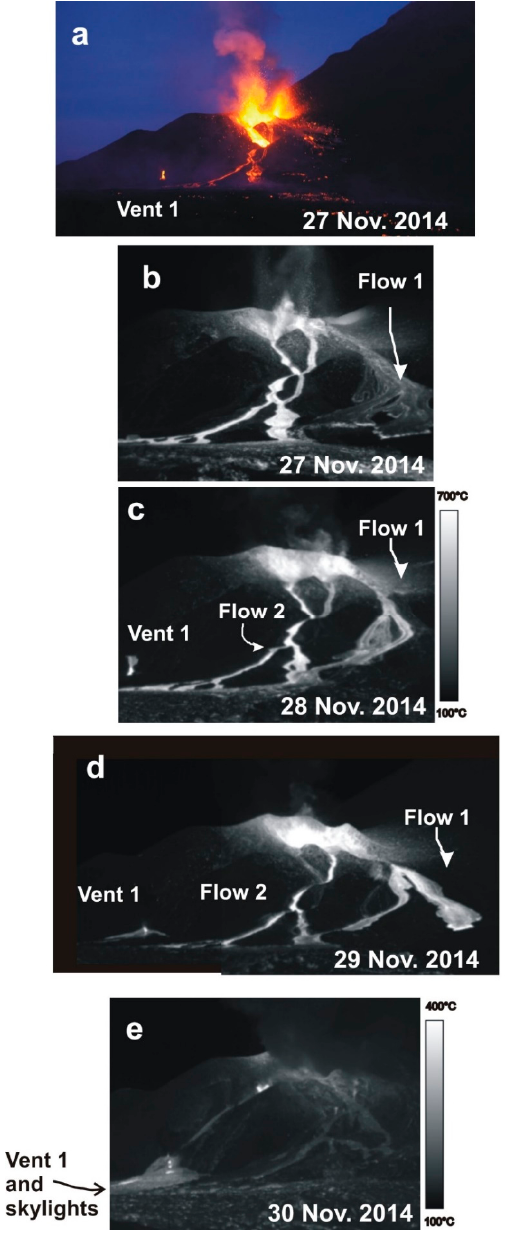
Figure 3. Lava tube formation and growth during the early stages of the eruption shown by photo and thermal images. ( a ) Photo taken from SW (Mt. Beco, see Figure 1) on 27 November 2014 showing the opening of Vent 1 at the base of the eruptive fissure; and ( b ) thermal image collected on the same day, showing lava overflows from the S crater rim feeding several branches overlapping Flow 1. Powerful Strombolian activity occurred from seven vents along the fissure. ( c ) Thermal image displaying a decreased explosive activity from two active vents within the cinder cone, several overflows from the S crater rim overlapping Flow 1, and Vent 1 at the base of the eruptive fissure. ( d ) Composition of two overlapped thermal images, displaying a significant erosion of the S crater rim by lava overflows (right of the image), and a small tumulus formed by lava accumulation around Vent 1 (left of the image). ( e ) Thermal image collected on 30 November 2014, displaying the inactive overflows from the crater rim, and Vent 1 at the base of the fissure forming a much higher tumulus than the previous day, with several skylights (white dots) displaying the path of the proximal lava tube. Note the much smaller range of the thermal scale (100–400 °C) to the right of this image when compared to the scales of previous thermal images (100–700 °C), suggesting a much cooler upper lava flow field.